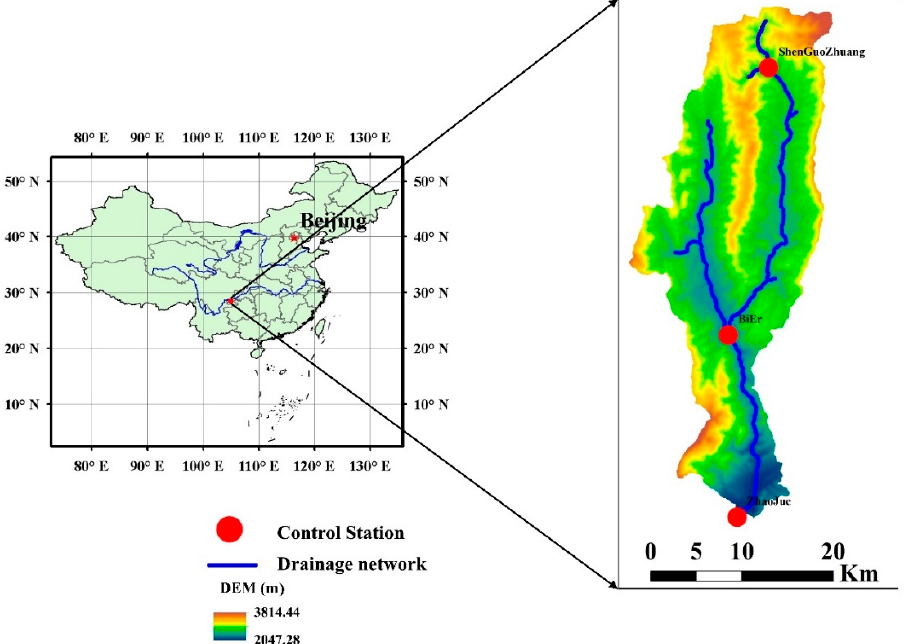
Figure 1. Map of the study area.